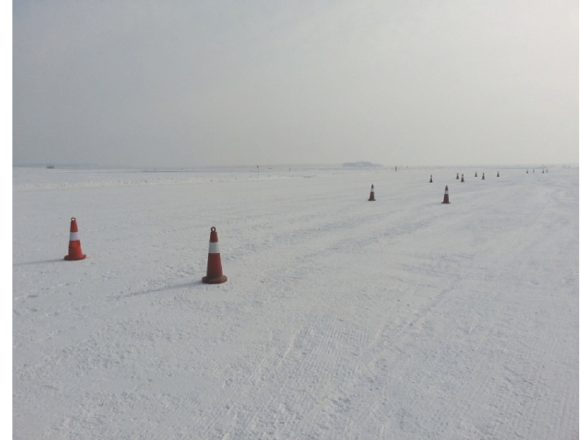
Figure 9: Double lane change test